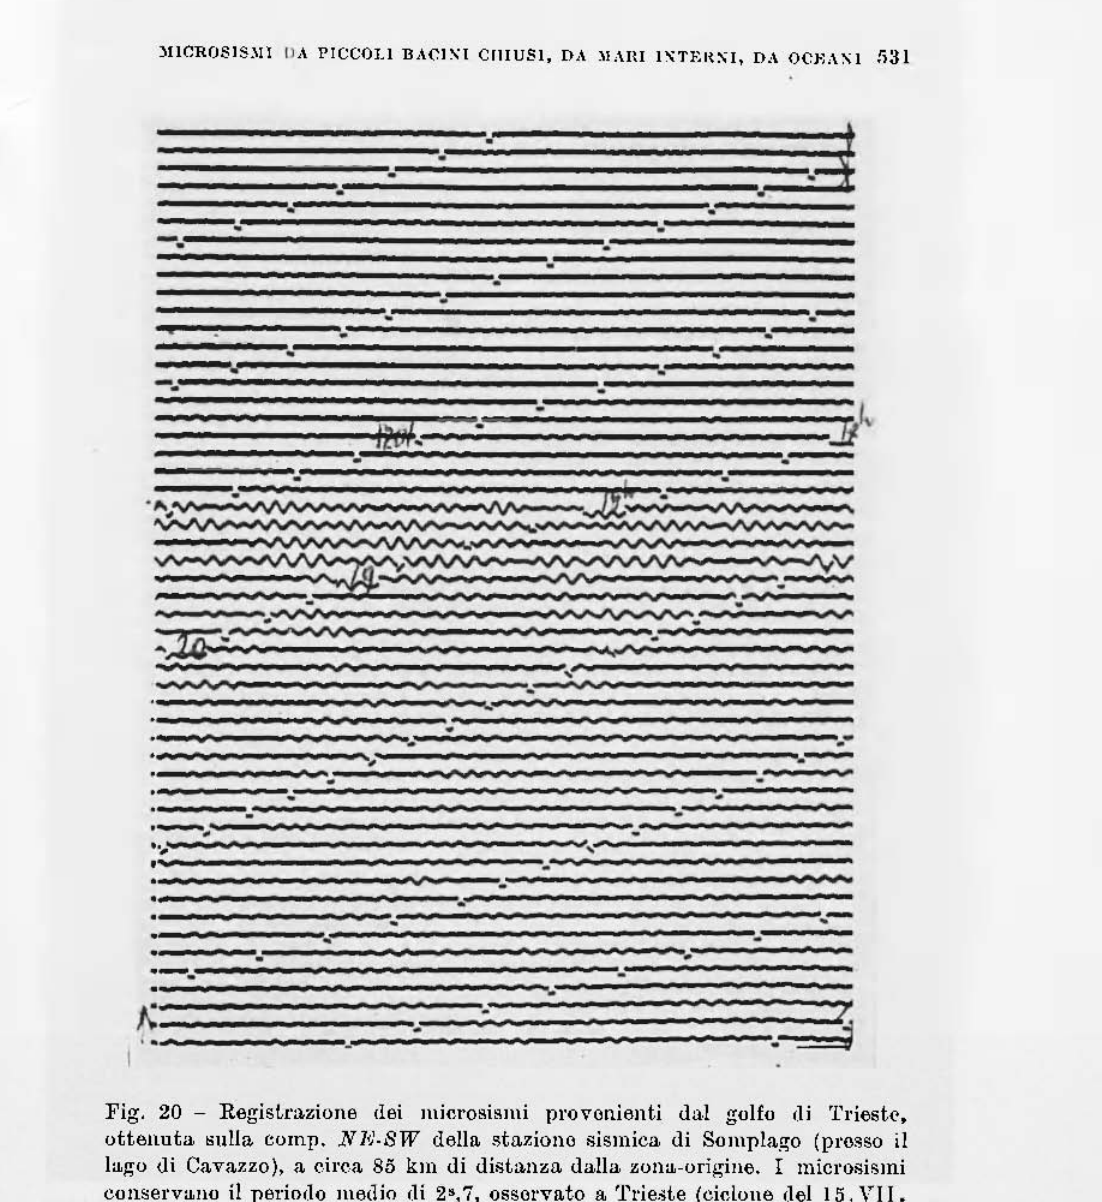
Fig. 20 - Registrazione dei microsisllli provonienti dal golfo di Trieste, ottenuta ~ulla cemp. NN·SW della staziono sismica di Somplag'o (prosso il lu.g-o di Cavazzo), a circa 85 km di distanza dalla zona-orig-in6. I microsismi conservano il periodo medio di 2',7, ossorvato a Trie.~te (ciclone del 15. VI I. 1970). Fig. 20 - Recordillg" of microseisms from tho GuU of Trieste, tuokell 011 the N E-SW componellt of the Somplago Seismic SbtiOll (near the Lako of Cavazzo), at about 85 kms distance from the origill